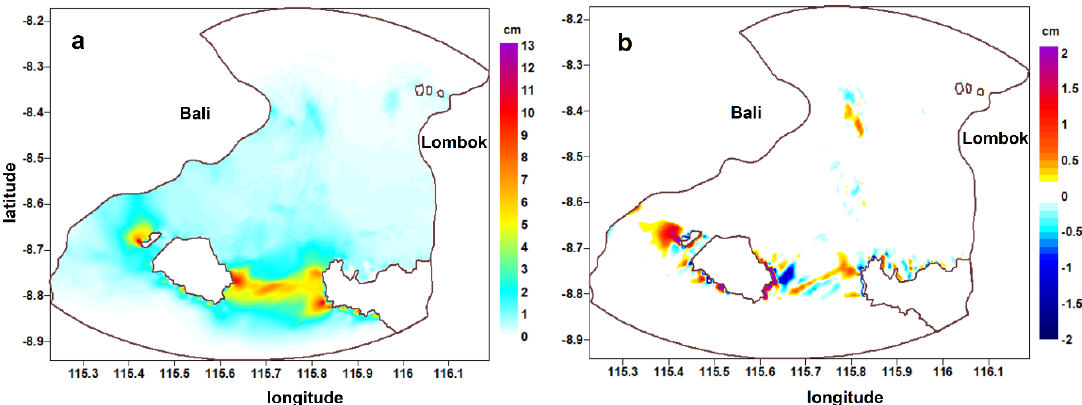
Figure 9. Nonlinearity in the sea surface height. ( a ) Hs approach; ( b ) the difference in the nonlinearity in the sea surface height between Hs and Nh approach.